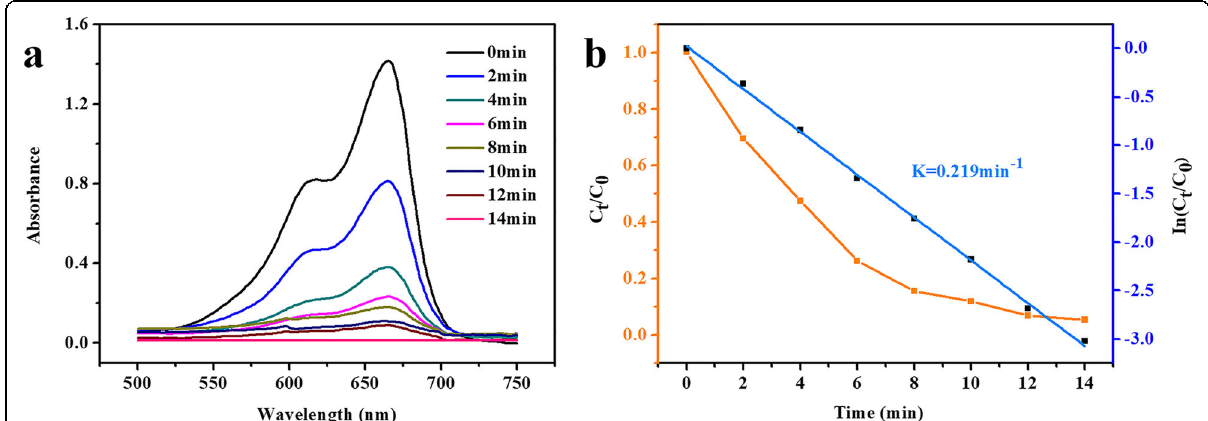
Fig. 10 Catalytic performance of GA@AgNPs-LA-CP for the catalysis of MB. Time-dependent UV-vis spectral changes a and the reaction kinetics curve b